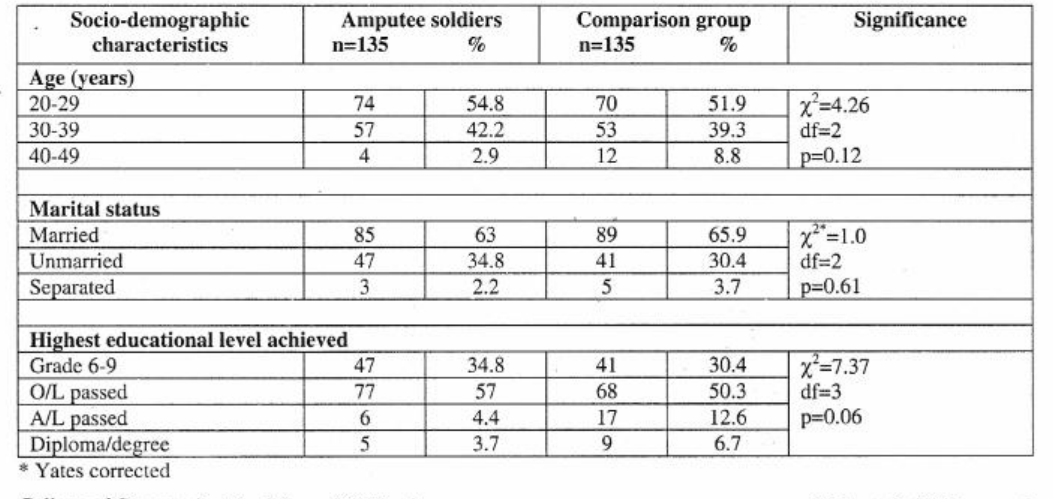
‘Table 1 : Distribution of some ofthe socio-demographic